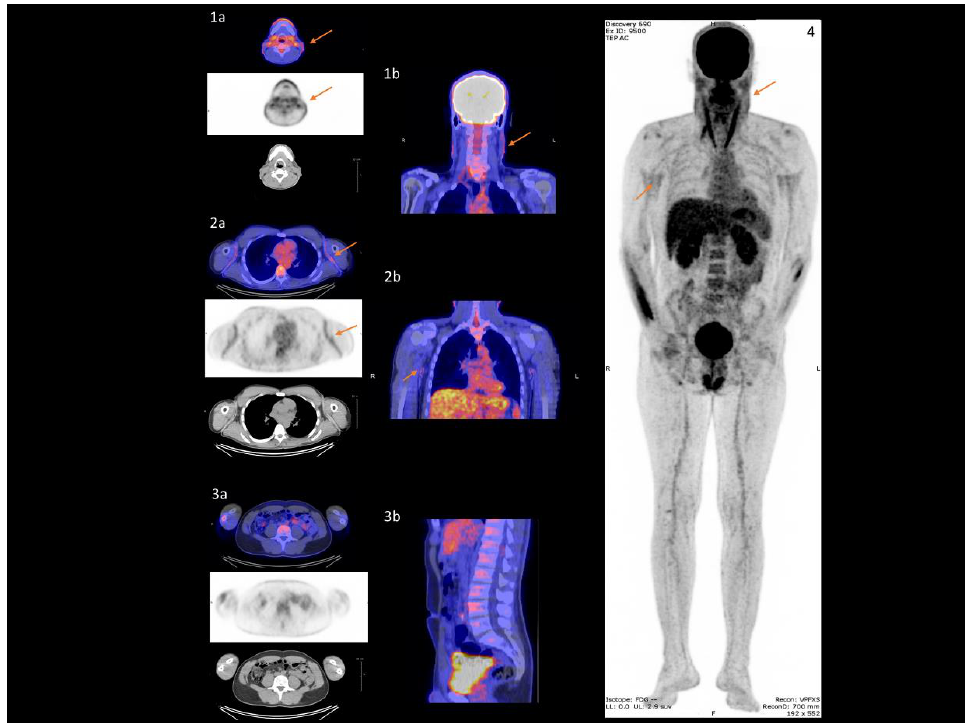
Figure 2. 18F-FDG uptake in specific damaged skin in PXE . Damaged skin in neck (arrows ( 1a , 1b )) and axillary folds (arrows ( 2a , 2b )) vs healthy skin in lumbar region ( 3a , 3b ) on PET/CT imaging. Maximum intensity projection indicates damaged skin sites (arrow 4).